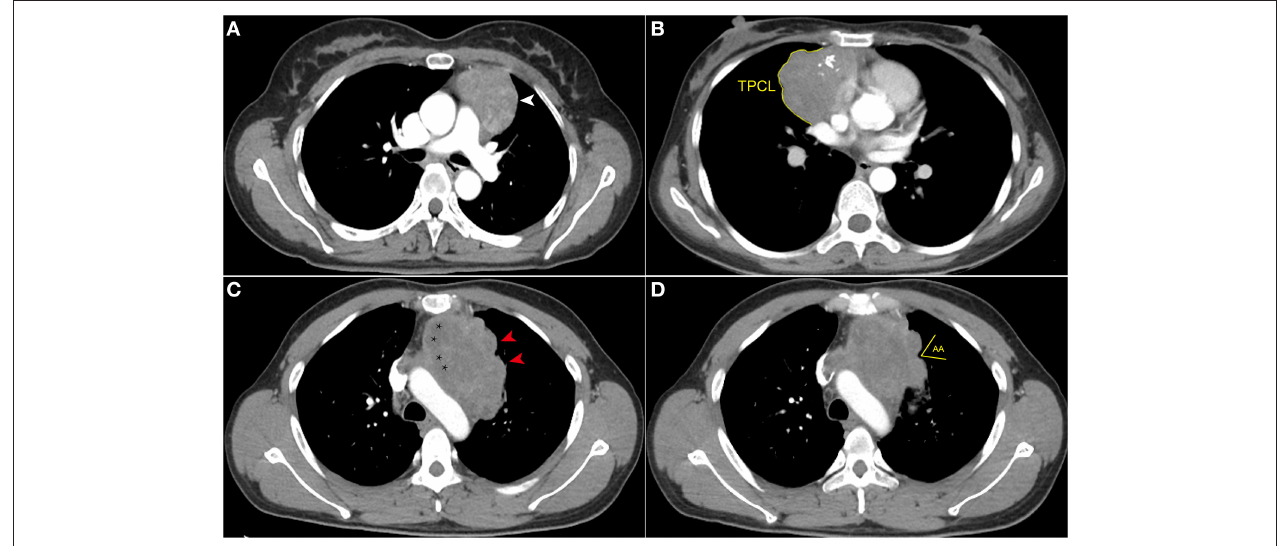
FIGURE 2 | Computed tomography imaging evaluation of contour, internal density, and measurement of the new index. (A) Axial contrast-enhanced chest CT image obtained at the level of the pulmonary trunk demonstrated a thymoma with smooth contour (white arrowhead) in a 42-year-old woman (WHO classification AB). (B) Axial contrast-enhanced chest CT image showed a thymoma (WHO classification B1) in a 54-year-old woman. The multilobulated contour and internal calcifications were seen, and the tumor perimeter that contacted the lung (TPCL) was measured along the margin between tumor and adjacent lung (yellow arc line). (C) Axial contrast-enhanced chest CT image obtained at the level of the aortic arch demonstrated a thymoma (WHO classification B2) in a 49-year-old man who complained of chest distension and chest pain. The tumor has several obtuse angles formed by adjacent lobulations (red arrowhead), and low-density cystic or necrotic areas are indicated by stars. (D) In the same patient as (C) , the acute angle (AA) formed by adjacent lobulations can be seen in the upper